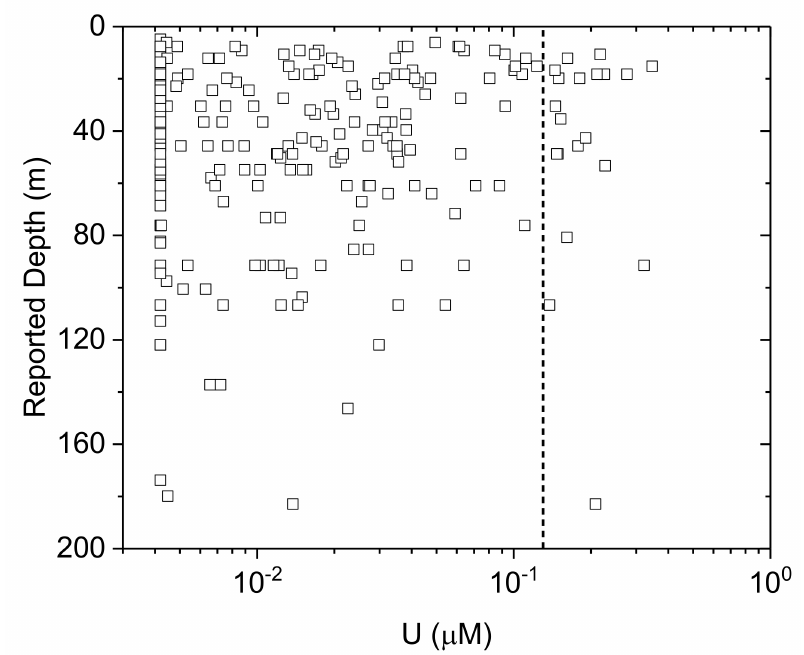
Figure 12. Depth versus U (log-scale) with the WHO provisional guideline [4] of 0.13 µ M (30 µ g.L − 1 ) for U in dotted line. Samples with measured concentrations below detection are shown as maximum concentration at method detection limit.